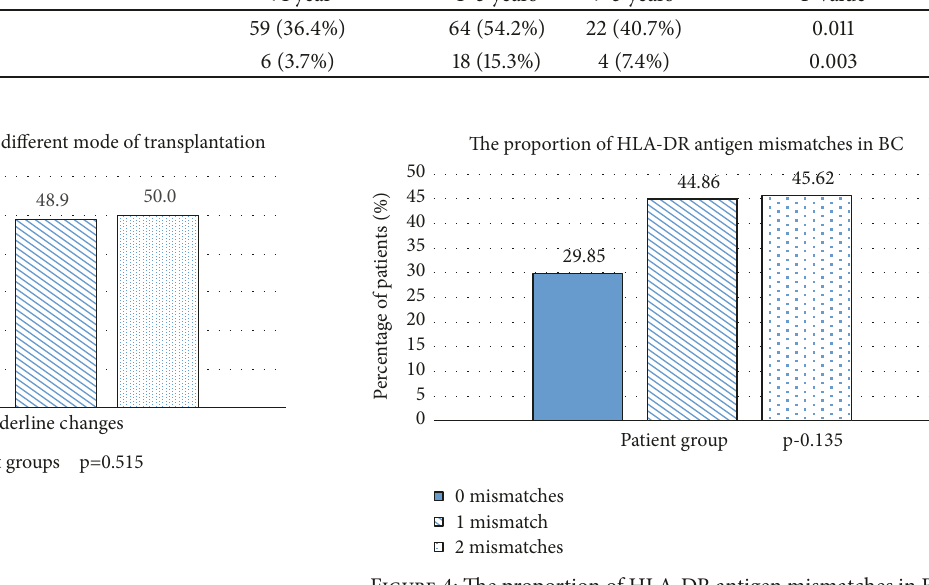
Figure 2: Incidence rate of BC in the different mode of transplanta- tion.